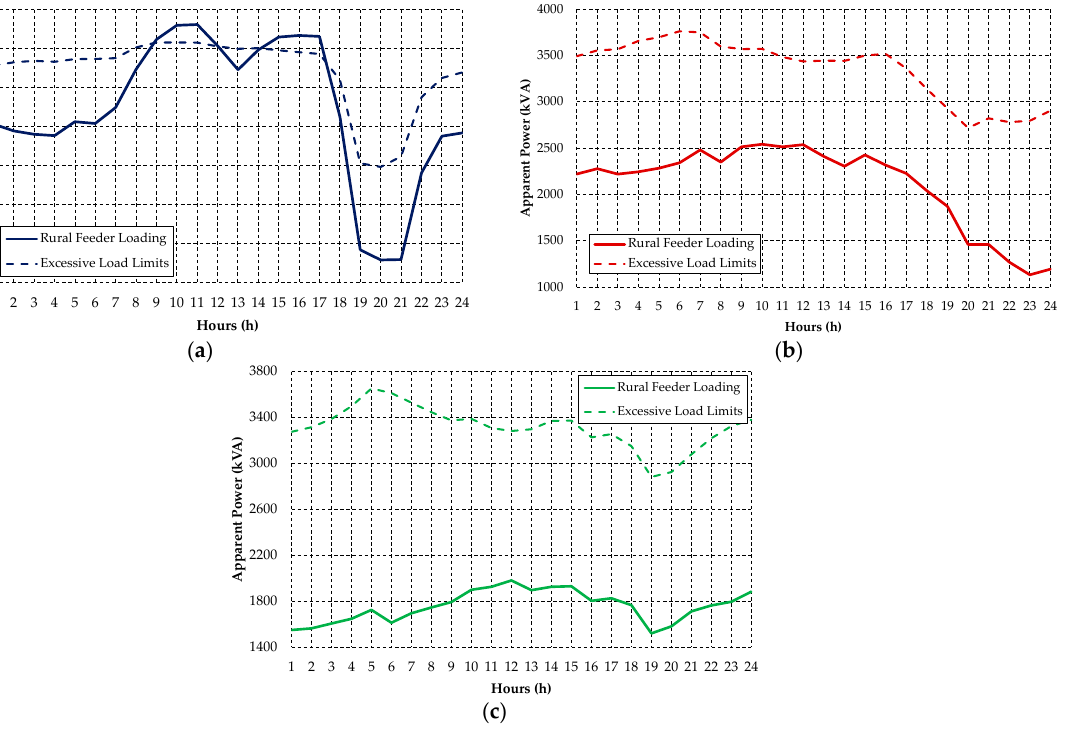
Figure 10. Apparent power and limits for excessive loading on the Rural Feeder A in the period of ( a ) weekday, ( b ) Saturday, and ( c ) Sunday. Source: The authors.